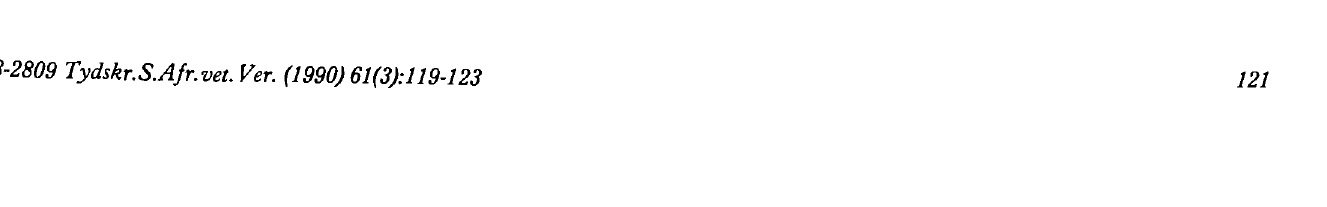
table to the development of the bent-leg syndrome. Of the 18 rams used in this stud, 5 had a reasonably high percentage of bent-leg offspring ranging from 13,3%